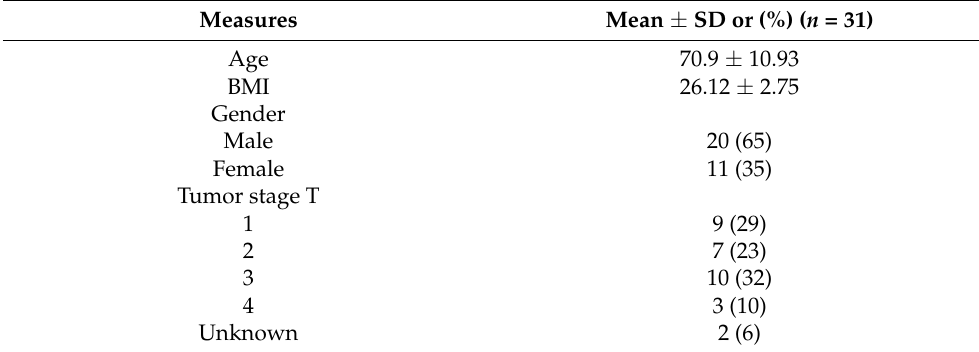
Unknown 2 (6) Values are presented as mean ± standard deviation or number (%). BMI: Body Mass Index.